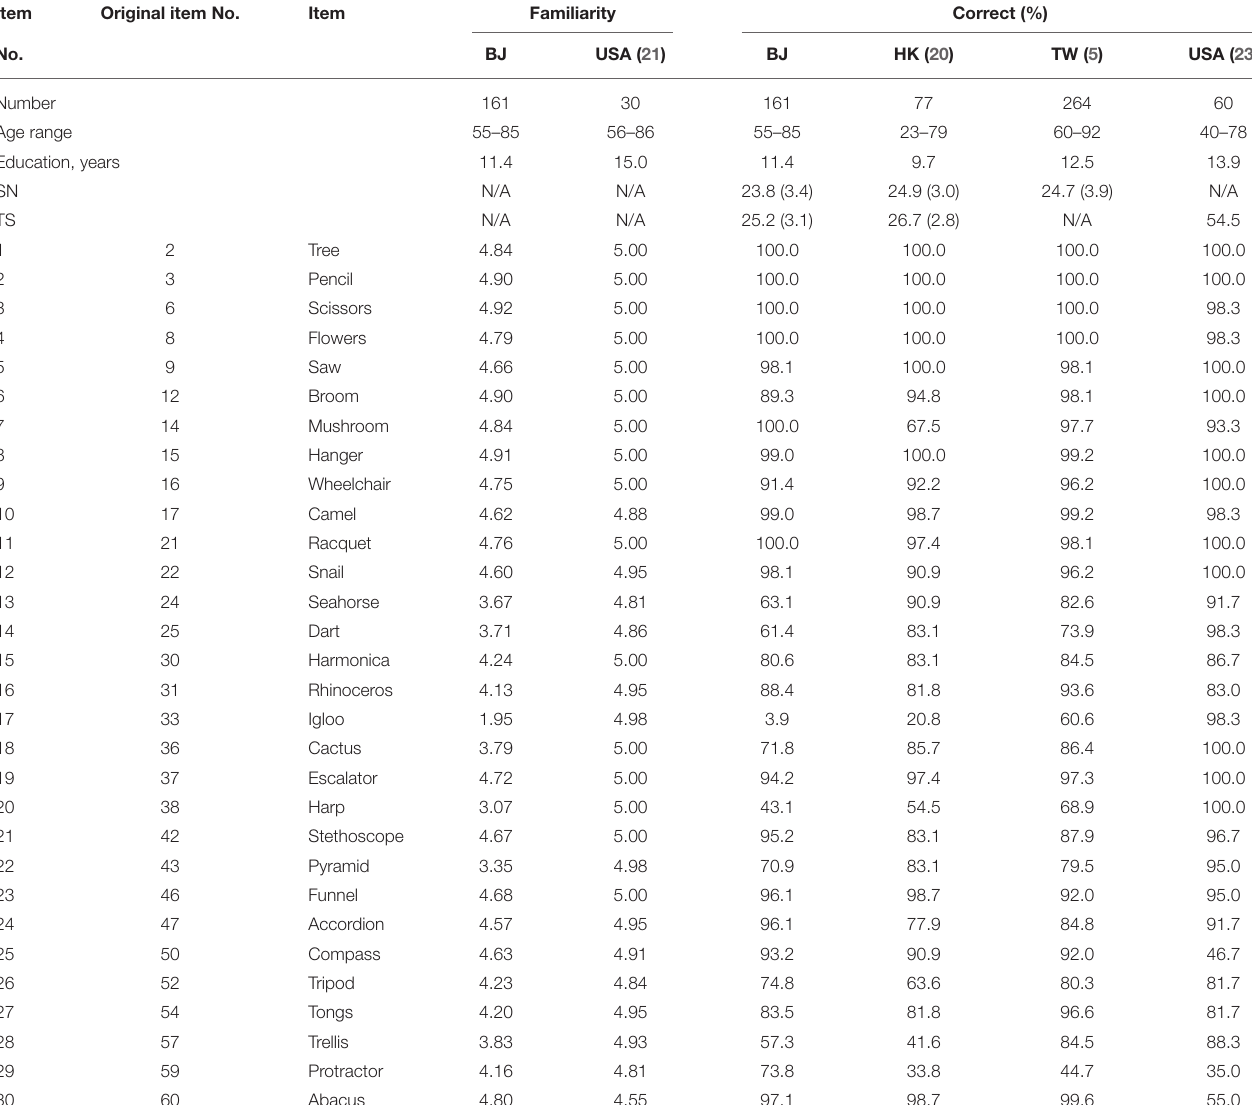
TABLE 2 | Per-item familiarity and correct naming rate of BNT-C in our study and other studies. Item Original item No.